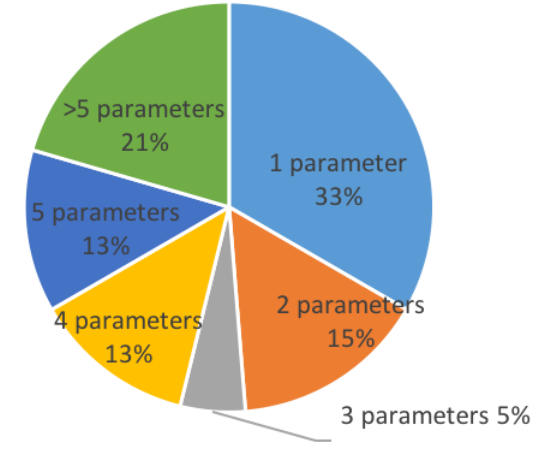
Figure 6. Number of e-monitor parameters used.